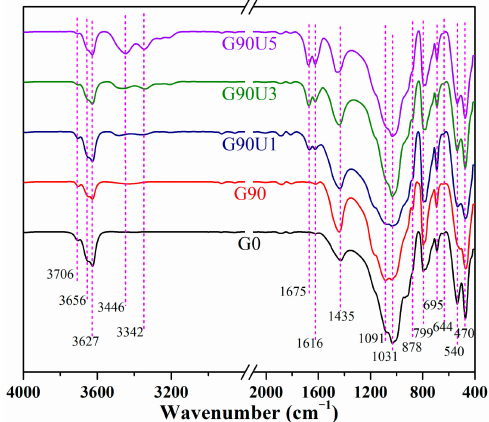
Figure 5. FTIR spectra of G0, G90, G90U1, G90U3, and